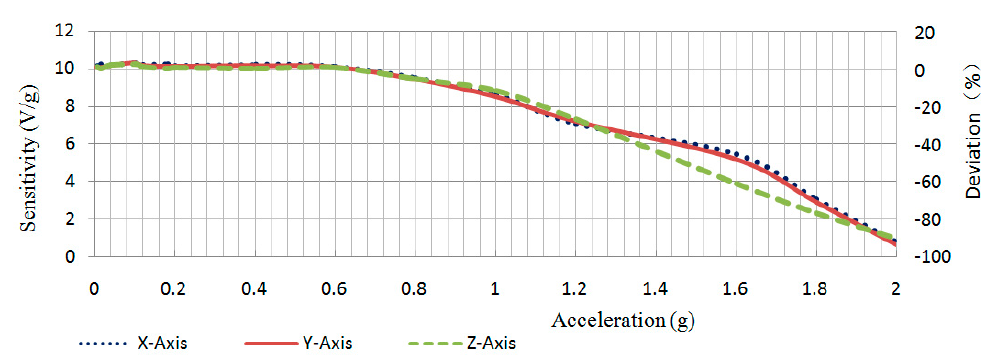
Figure 10. The plot of adaptive sensitivities with the amplitude of inputs.